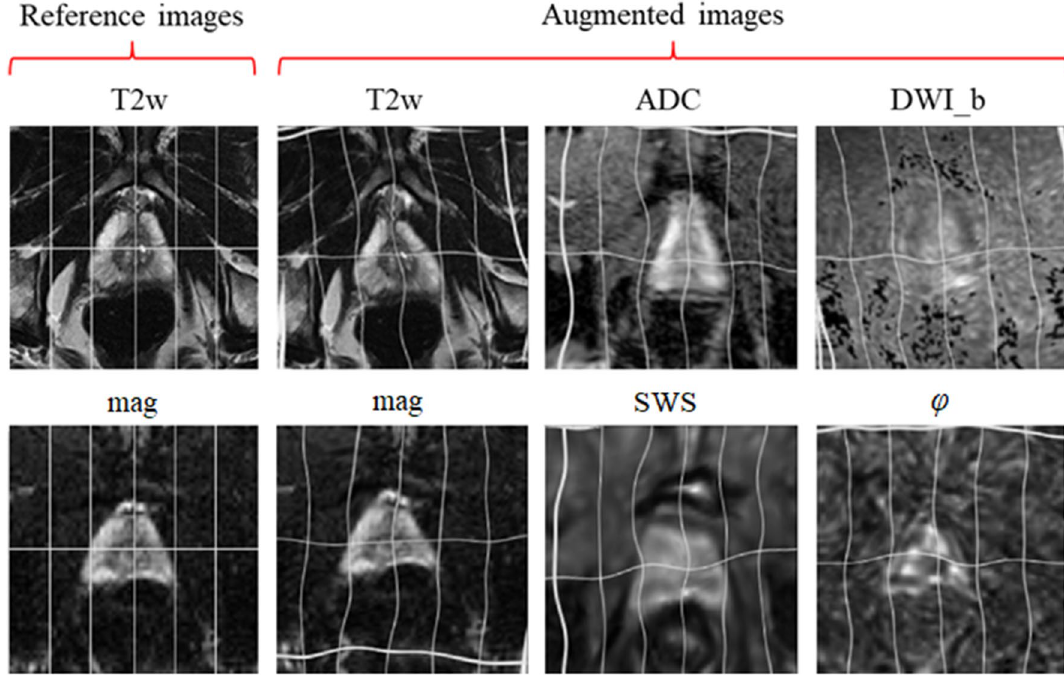
Figure 2. Image augmentation using elastic deformation. First column shows the reference non-augmented T2w images in the first row and MRE magnitude maps (mag) in the second row. Augmented images are shown in the remaining columns: first row: T2w, ADC, and DWI_b. Second row: mag, SWS and ϕ .